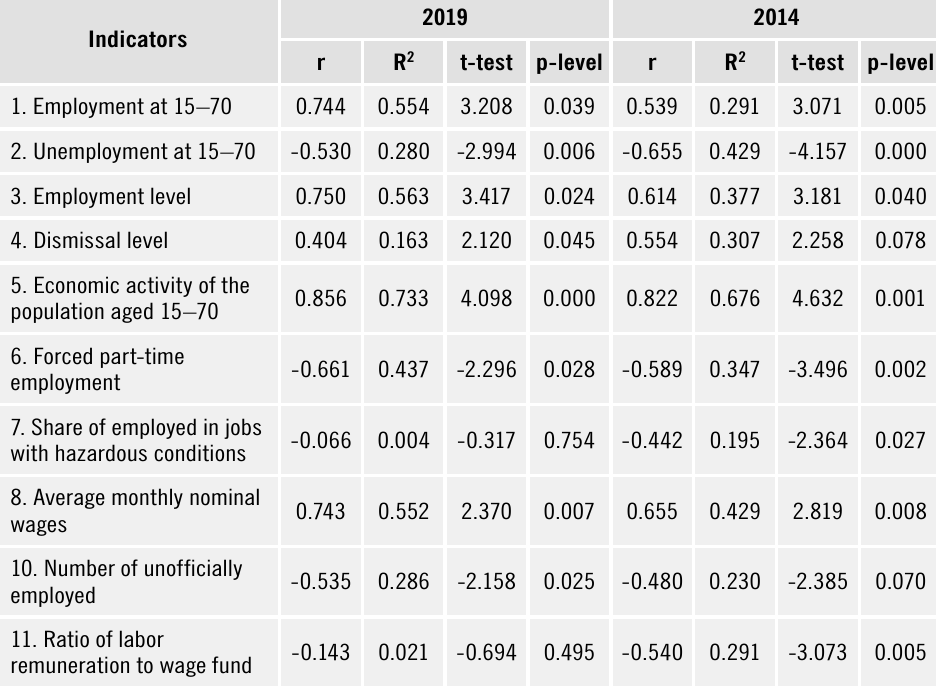
Table 5. Results of the analysis of the relationship between net interregional migration rate and labor market condition indicators in Ukrainian regions in 2014 and 2019 2019 2014 Indicators r R 2 t-test p-level t-test p-level